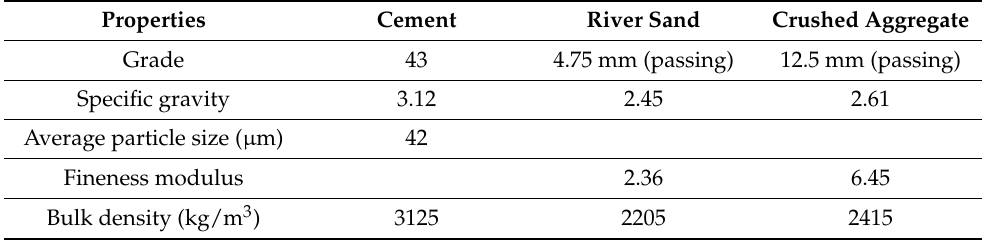
Table 1. Properties of the concrete